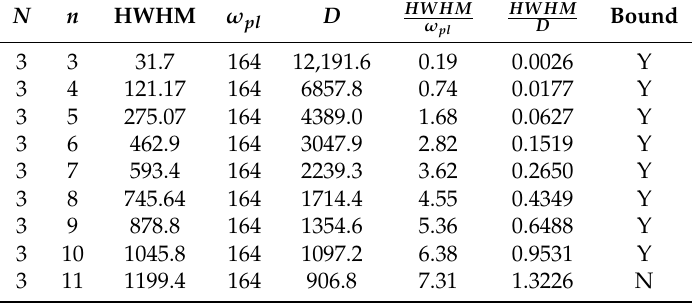
Table 3. Widths vs. plasma frequency ω pl and distance D to the continuum for CONVST with strong collisions as a function of the upper level principal quantum number n . All energies are in cm − 1 and densities N in 10 17 e/cm 3 . The ’Bound’ column indicates whether the state is considered bound (Y) or not